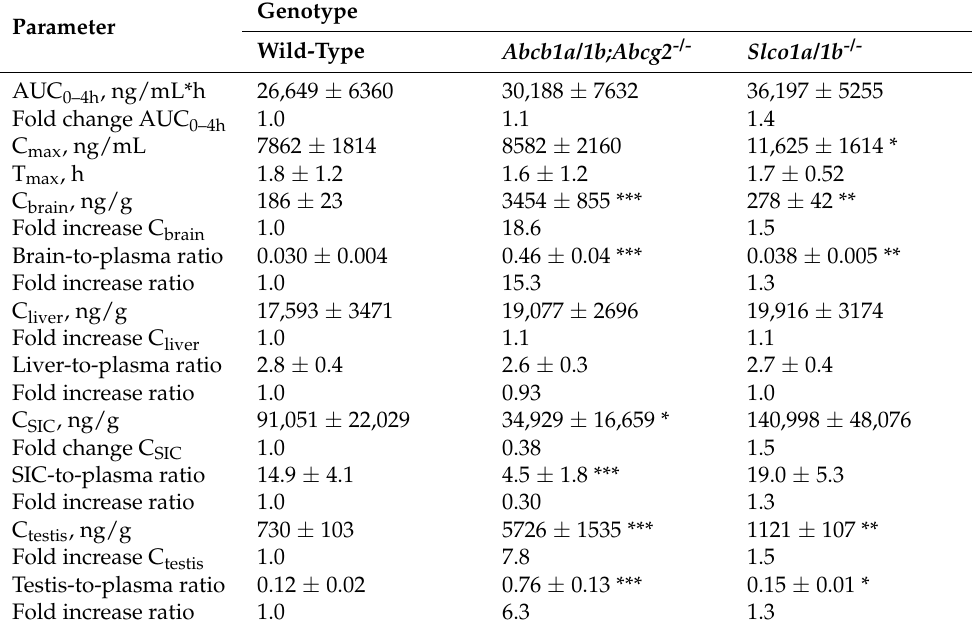
Table 1. Plasma and organ pharmacokinetic parameters of selpercatinib in male wild-type, Abcb1a/1b; Abcg2 -/- and Slco1a/1b -/- mice over 4 h after oral administration of 10 mg/kg selpercatinib. Genotype Parameter